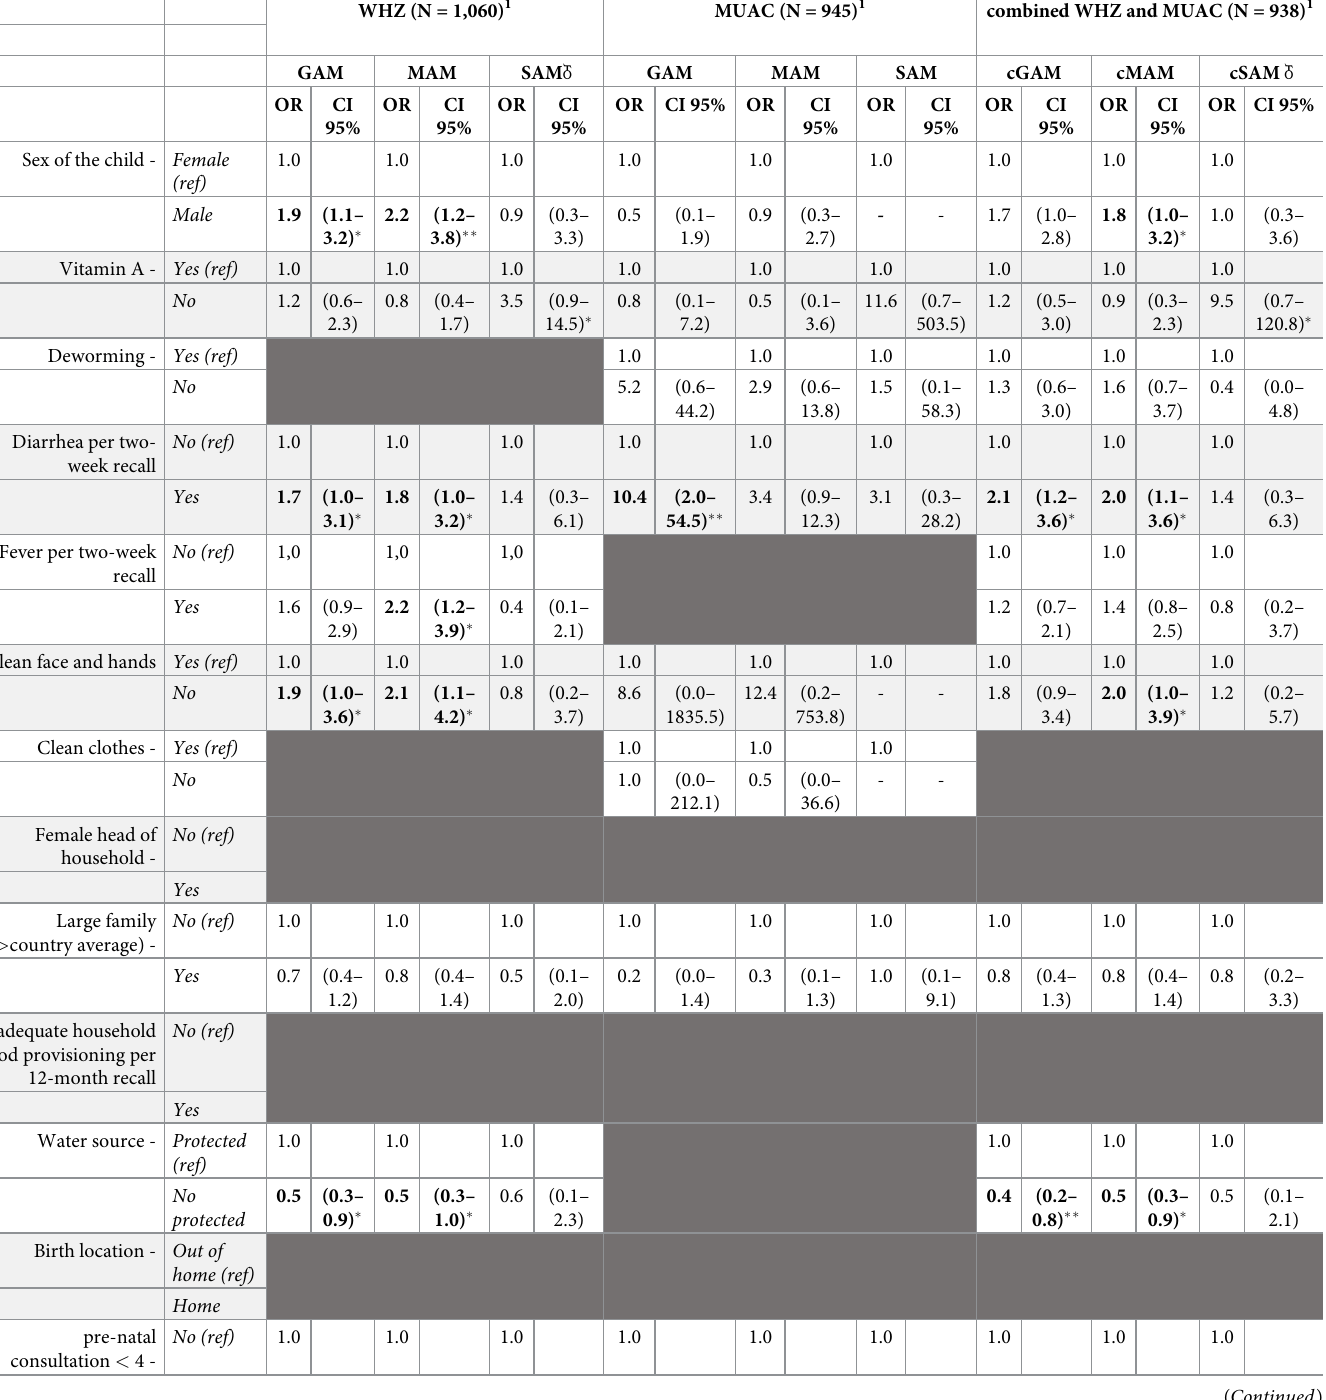
Table 4. Multivariate models between anthropometric categories and risk factors for